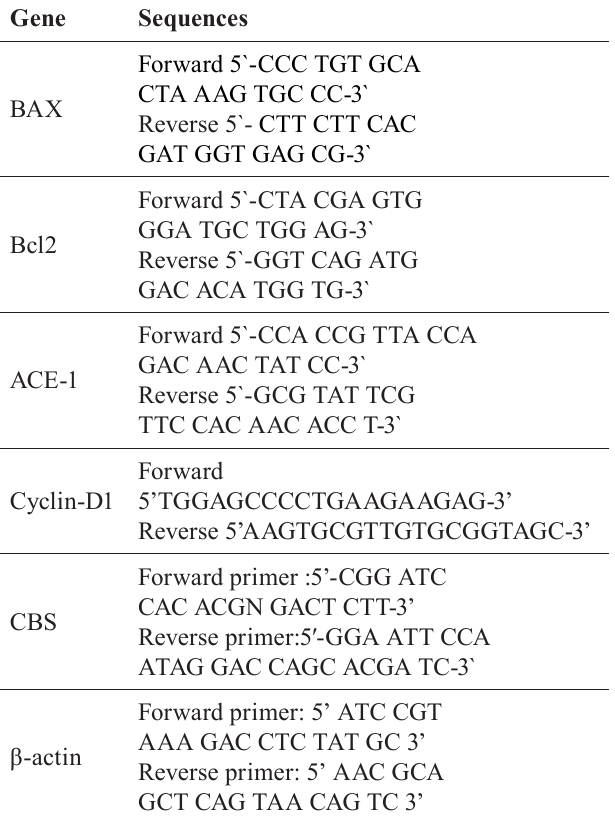
Table I - P rimer sequences for